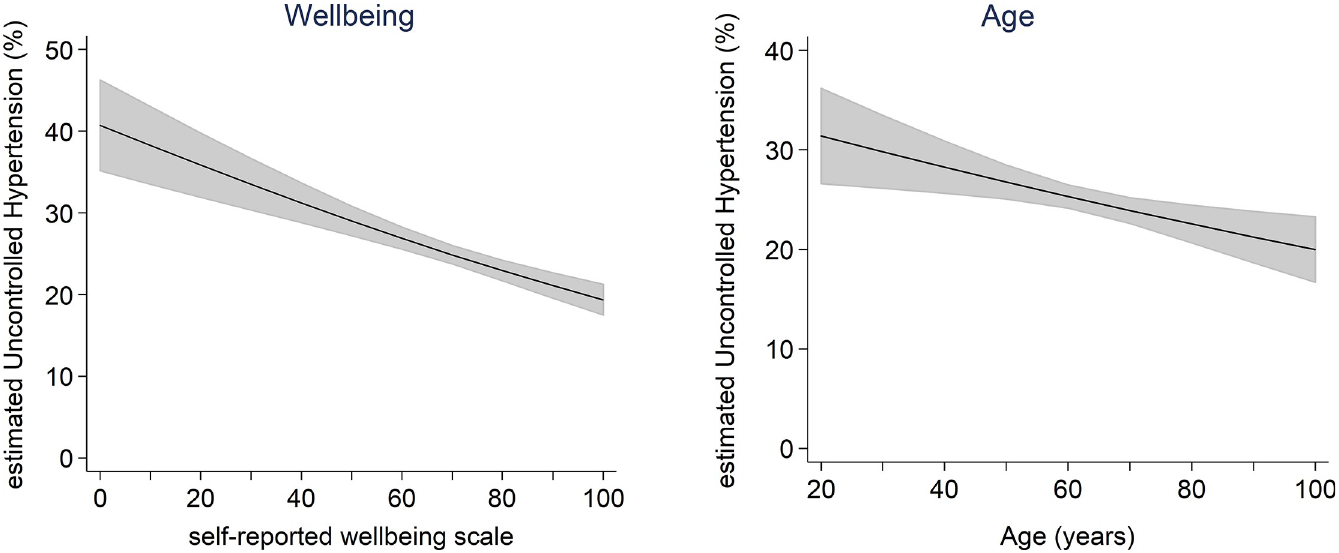
Fig 1. Predicted association between Uncontrolled Hypertension and two continuous variables, Wellbeing (left) and Age (right). The trends were estimated using a mixed logit regression model of Uncontrolled Hypertension. Summary measures of these associations are listed in Table 5: the level of Uncontrolled Hypertension was predicted to decline by 7% with a 10% increase in self-reported Wellbeing (p < 0.001), and by 5% with a 10-year increase in age (p = 0.003). Shaded areas represent 95% confidence